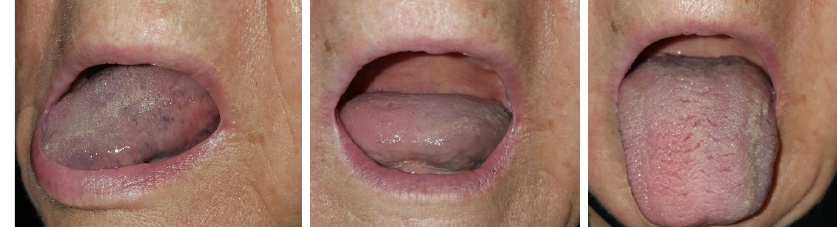
Figure 1. Unilateral cyanosis on tongue in our